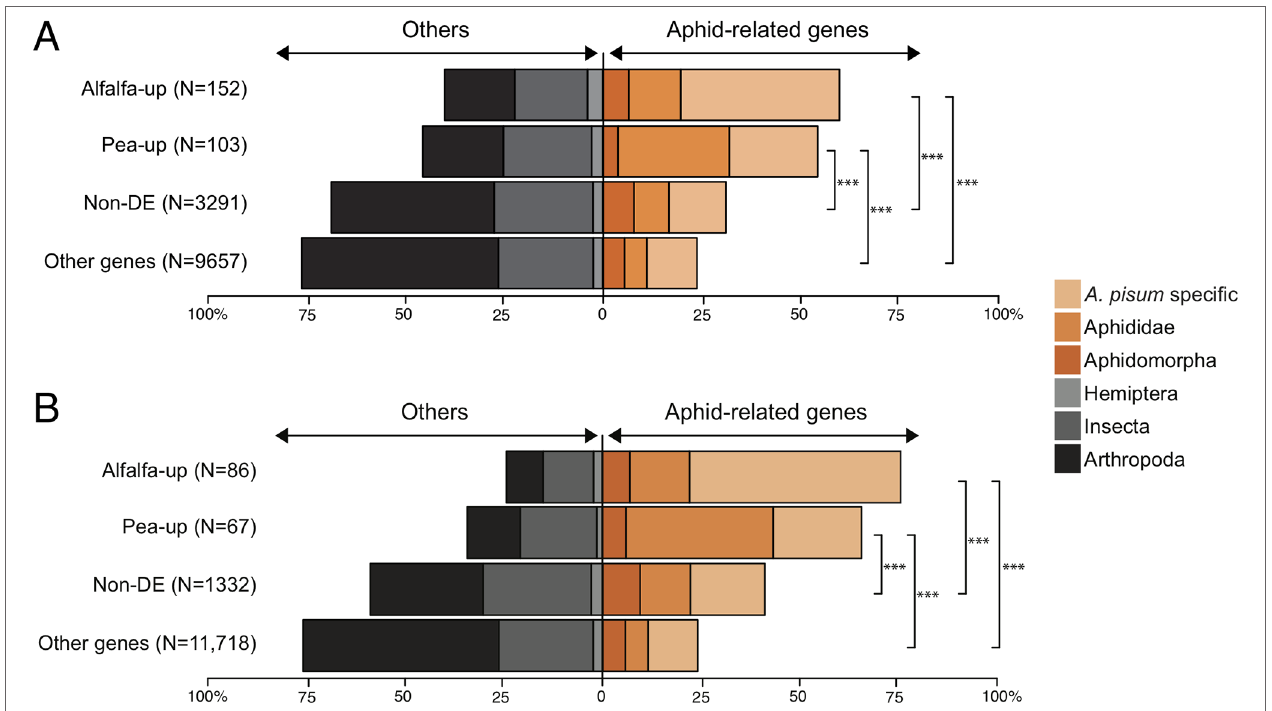
FIGURE 4 | Orthology profiles of candidate salivary (A) and salivary upregulated (B) effector sets. Proportions of the different orthologous categories in the salivary effector sets and the other A. pisum genes that were considered as expressed in this study are shown. Asterisks indicate the significance of differences in the proportion of genes that belong to the same orthologous categories (proportion test, *** P < 0.001). Orthologous categories were assigned by Boulain et al. (2018), based on an OrthoDB analysis using 17 insect